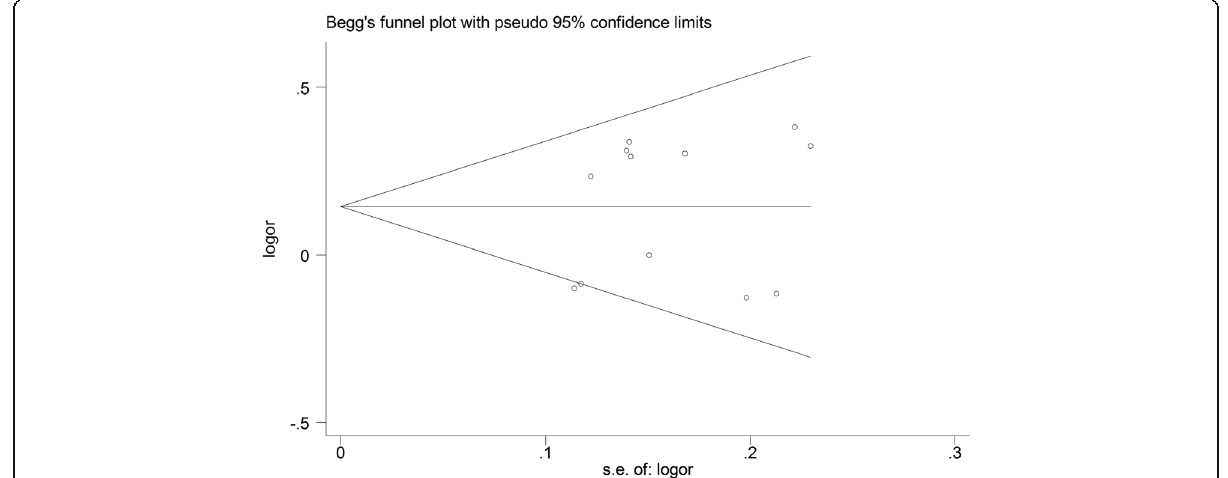
Fig. 5 Funnel plot to assess publication bias for the association of VEGF -2578C > A gene polymorphism with lung cancer susceptibility in overall